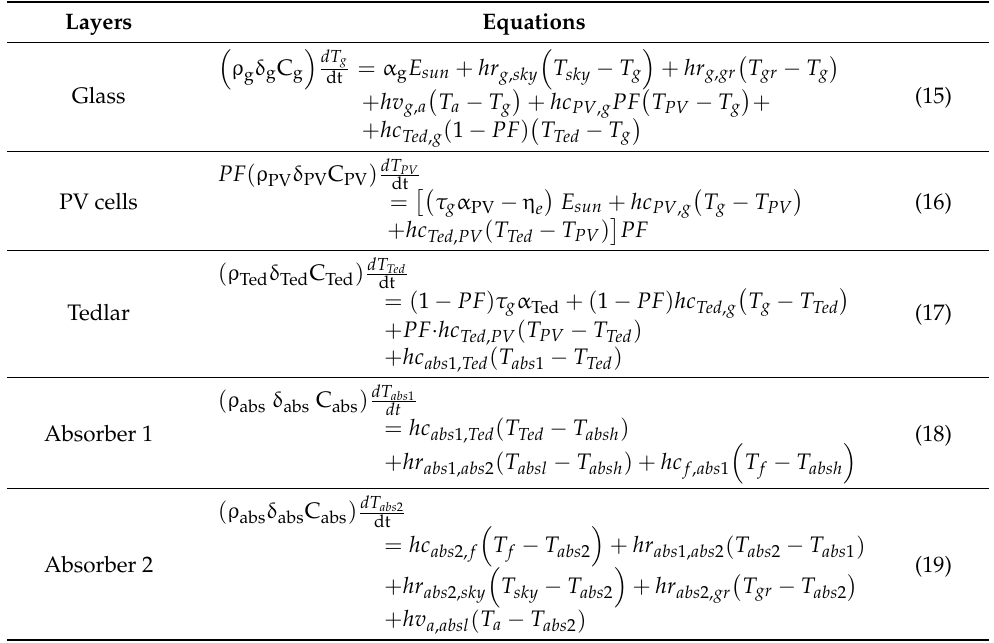
Table 3. Governing equations for the PV/T solid